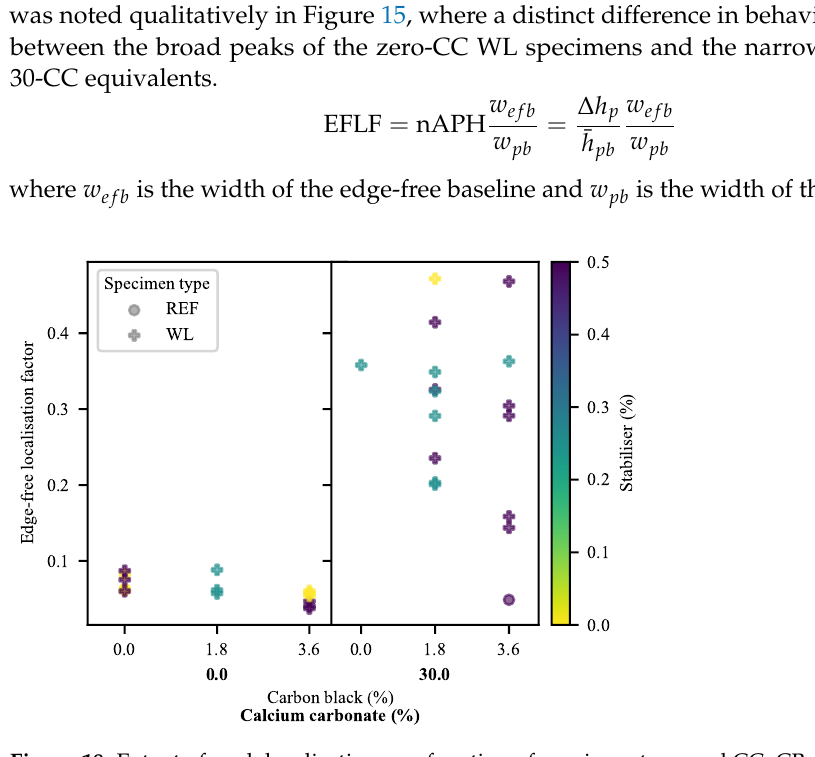
slight. This is frequently followed by a second and more localised/distinct whitening perpendicular to the direction of extension at the weld line in WL